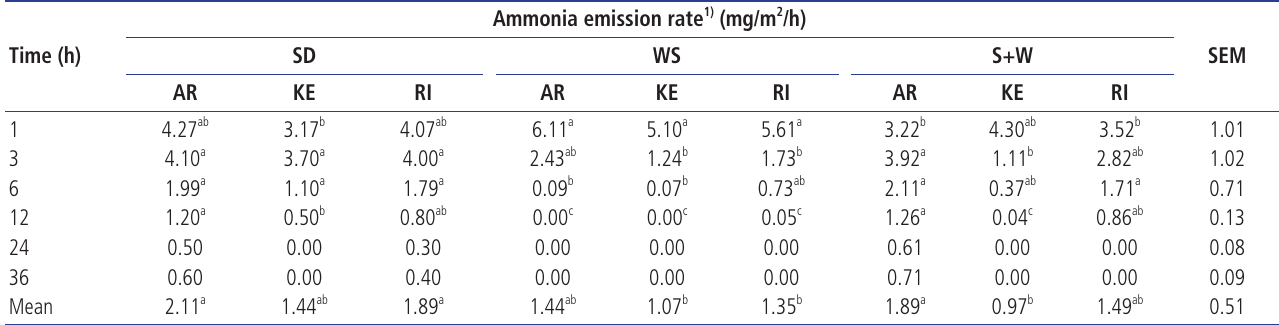
Table 5. Ammonia emission of bedding materials by the species of pine trees measured by the chamber system Time